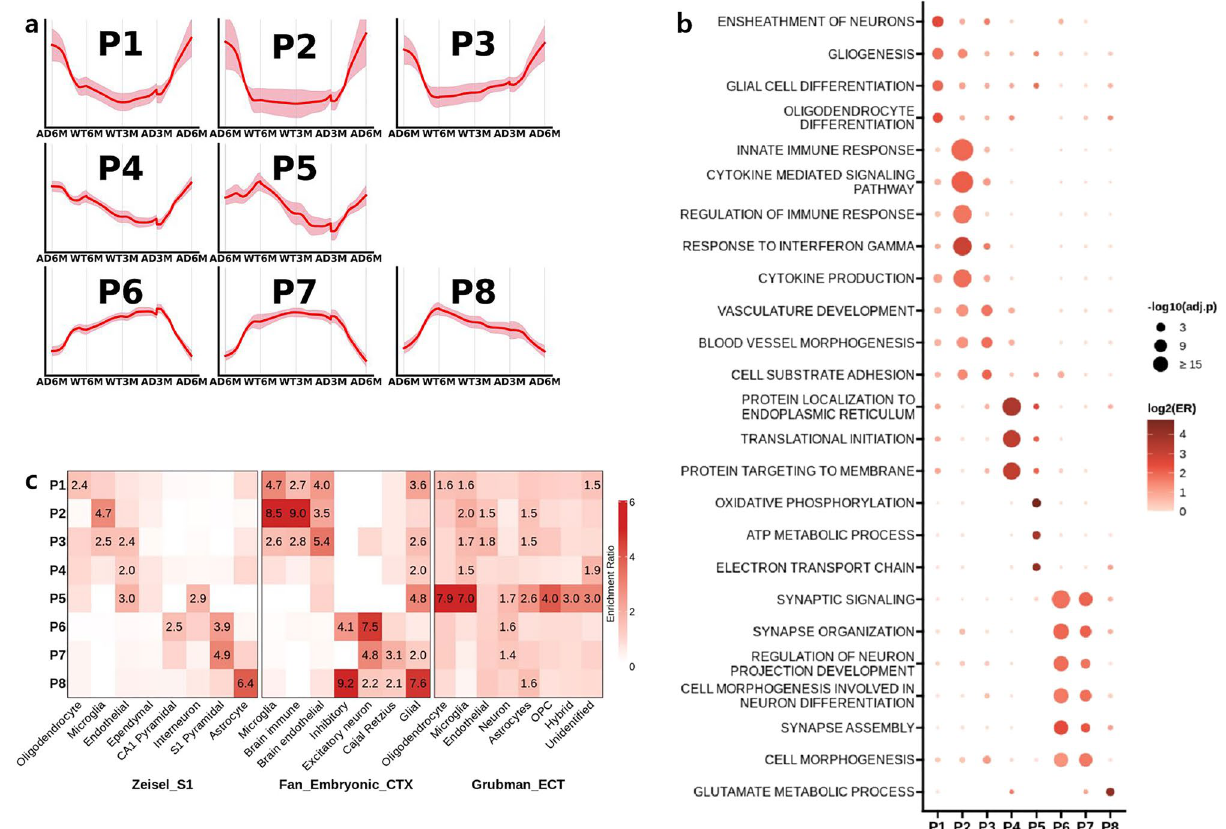
Figure 2. The eight pattern groups of GAN TCs. ( a ) Each pattern group showed up- or downregulation in the four-way TCs. The red line represents the average TCs in each pattern group. ( b ) Enriched Gene Ontology biological process terms of each pattern group. Statistical significance (adj.p, dot size) and ER (colour scale). ( c ) Cell-type enrichment of each pattern with mouse primary somatosensory cortex (Zeisel_S1), human embryonic cortex (Fan_Embryonic_CTX), and entorhinal cortex from postmortem AD patients (Grubman_ECT). adj.p, adjusted p value; ER, enrichment ratio; GAN, generative adversarial network.